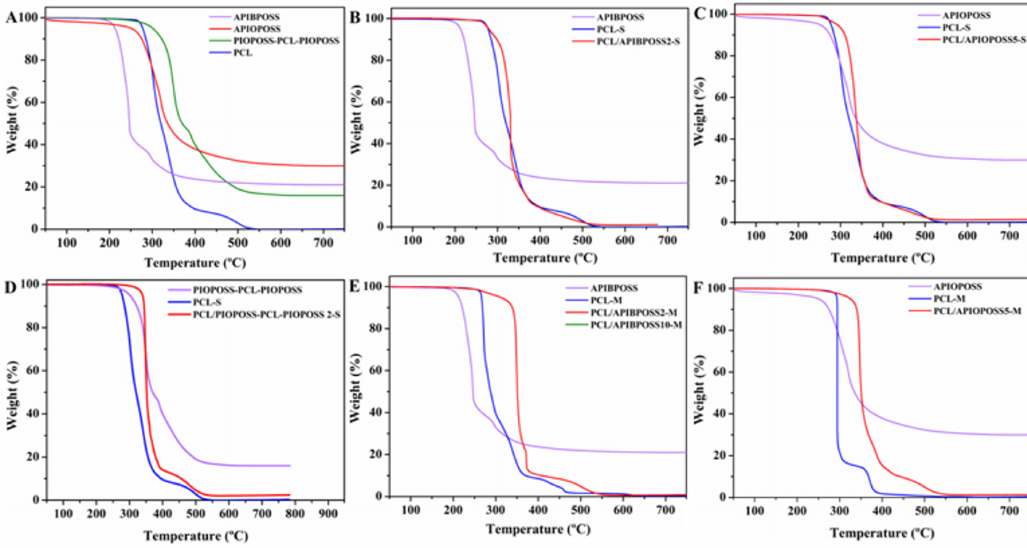
Figure 9. TGA curves of: ( A ) nanofillers and neat PCL; ( B – D ) solution blended nanocomposites; ( E , F ) melt mixed nanocomposites in O 2